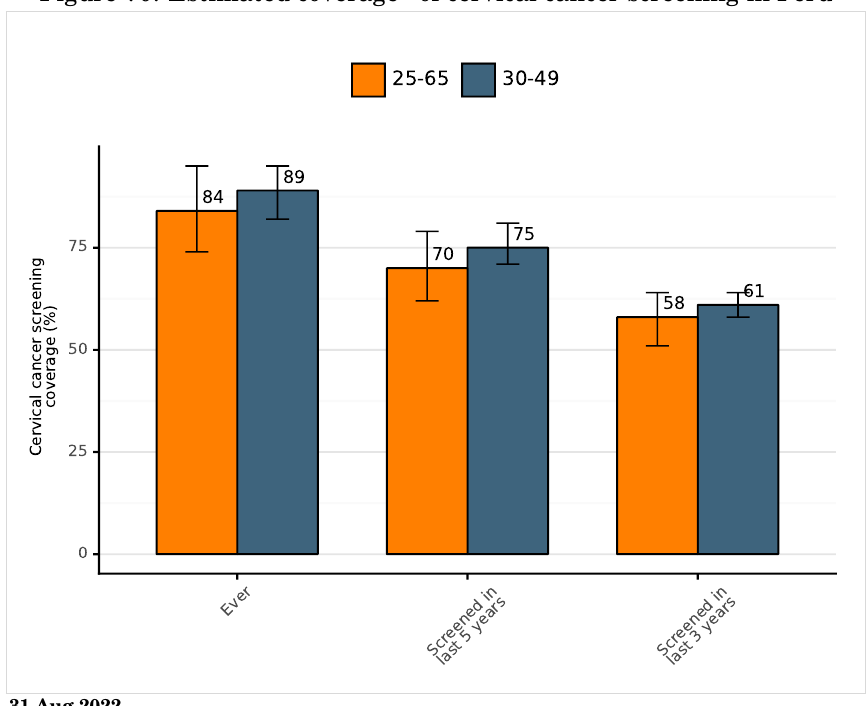
Figure 70: Estimated coverage* of cervical cancer screening in